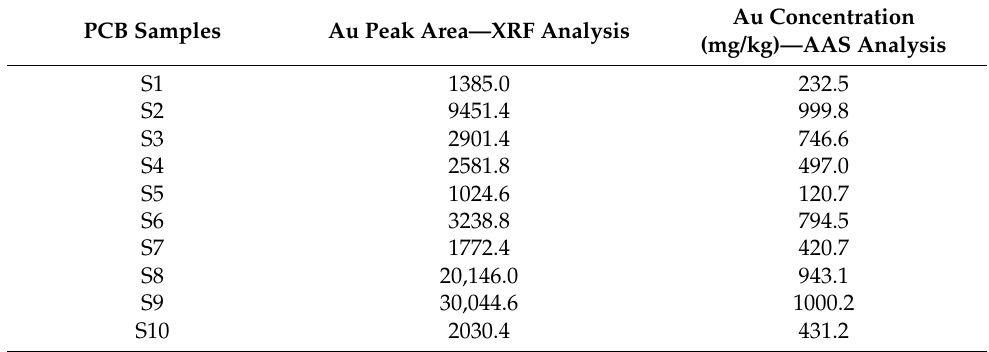
Table 1. Peak area for the XRF analysis and the relative concentration of gold obtained by